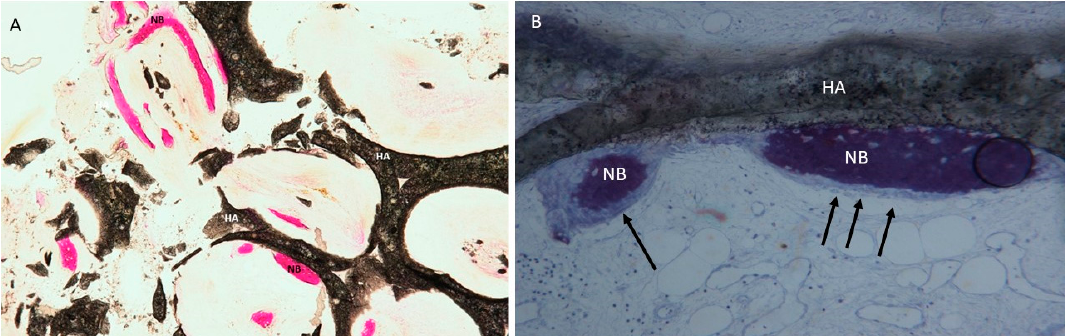
Figure 5. ( A ) A new trabecular bone (NB) was observed inside the interconnected pores of the HA scaffold (HA). Acid fuchsin and toluidine blue staining 10×. ( B ) The new bone (NB) and osteoblasts (arrows) were observed in the internal portion of the block (HA). Toluidine blue staining 100× (× indicates the magnification power of the microscopical observation).